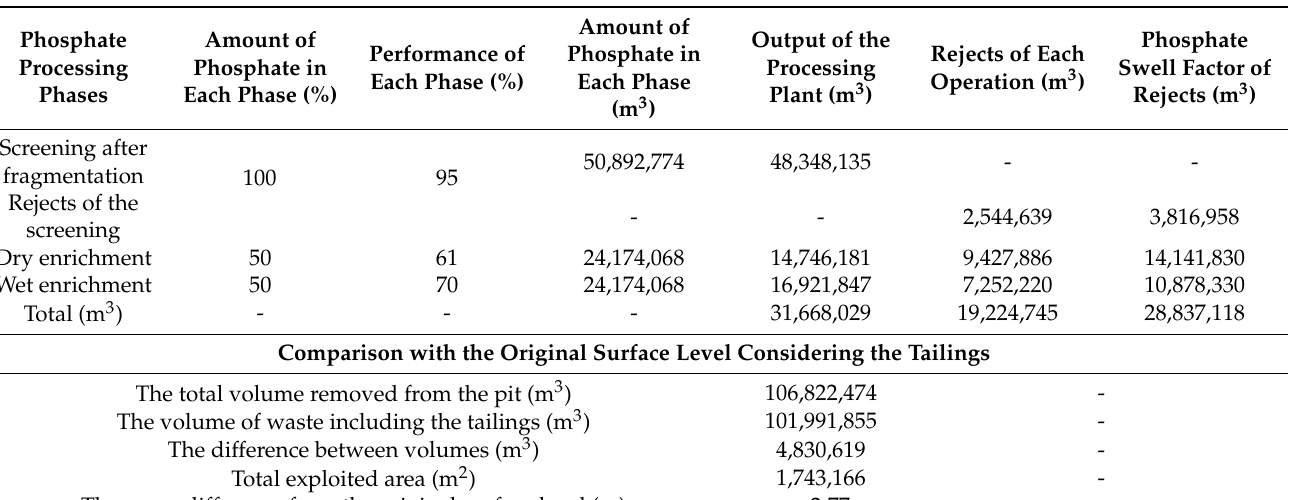
Table 3. Comparison with the original surface level of the exploited area and the tailings of the processing